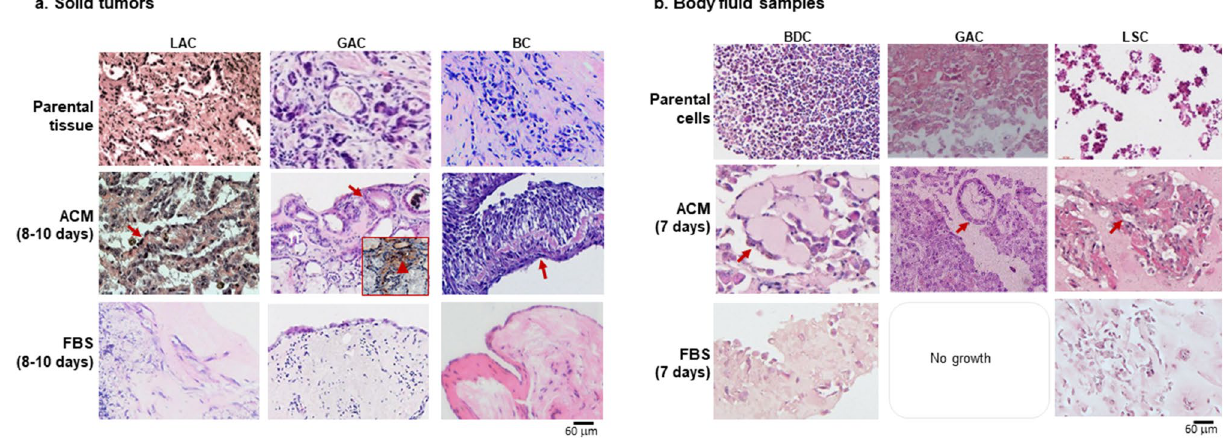
Figure 2. The similarity in histopathology of ACM-cultured tumors to parental cancers. Hematoxylin and eosin (H&E) stains. ( a ) Solid tumors; ( b ) Body fluid samples. Histopathology of different tumors: parental (top row), ACM cultures (middle row), and FBS cultures (bottom row) in ( a ) and ( b ) panels. Tissue-like structures formed in all ACM cultures (red arrows). The insert in ACM-cultured GAC shows that the newly formed glands were positive to PCNA, which means cells were still proliferating after 8–10 days in culture (red arrowhead). LAC: lung adenocarcinoma, GAC: gastric adenocarcinoma, BC: breast invasive ductal carcinoma, LSA: lung squamous cell carcinoma. Scale bar = 60 µm.